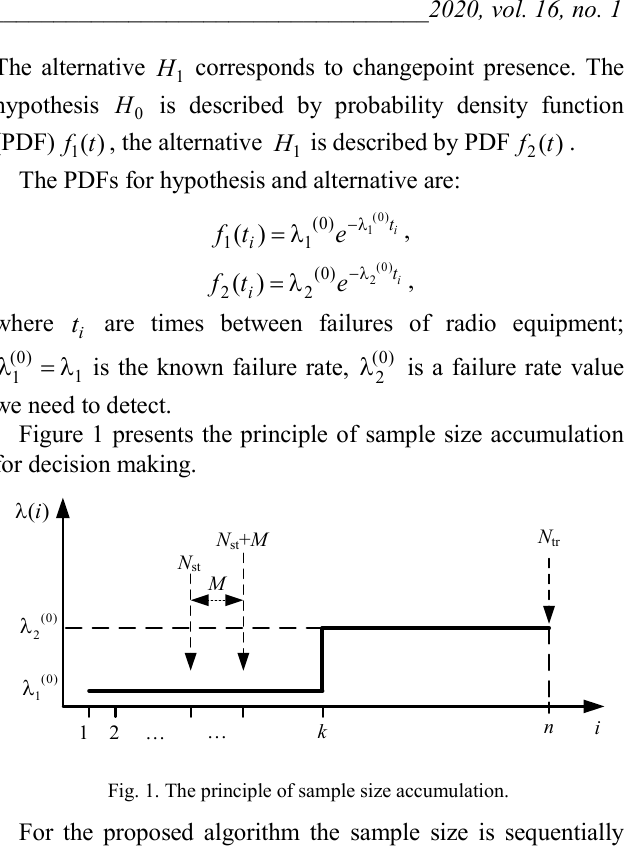
algorithm based on Neyman–Pearson criterion with sample size accumulation and threshold calculation according to Bellman’s approach.